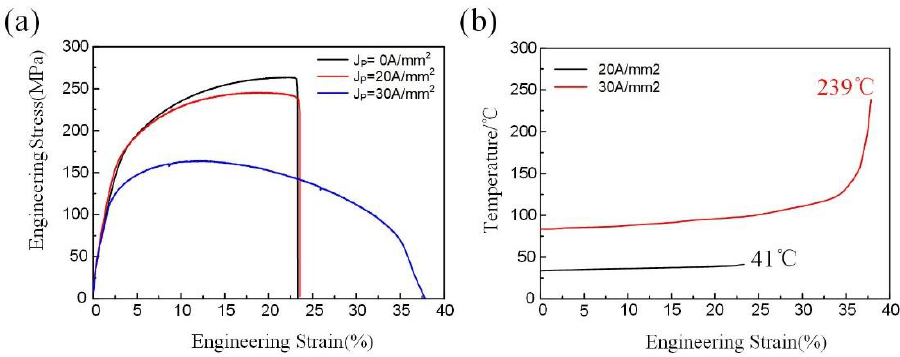
Figure 3. ( a ) Typical stress-strain curves; ( b ) temperature variations with strain curves under dif- ferent peak current densities (J P ). peak current densities (J P